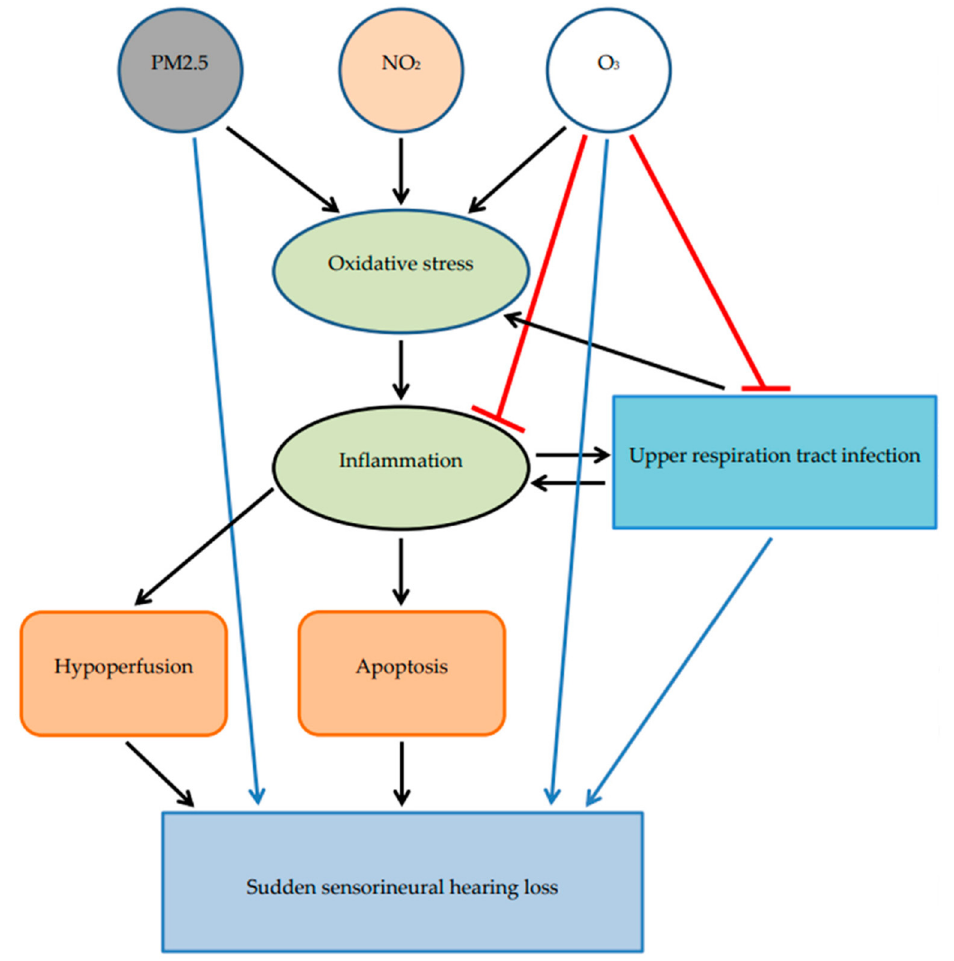
Figure 3. Possible mechanisms associated with air pollutants. The neurotoxicity of PM2.5 and O 3 directly affects cochlear cells (blue line). PM2.5, NO 2 , O 3 and upper respiration tract infection induce oxidative stress in the inflammatory pathway and cause apoptosis and hypoperfusion. Inflammation and upper respiration infection could interact and cause each other occur. (black line). PM2.5, NO 2 , and O 3 decrease the defenses of the upper respiratory tract, facilitating viral infections. Viruses directly infect cochlear cells (blue line) and induce oxidative stress and inflammation, causing SSHL. O 3 has an anti-inflammatory effect and can kill viruses (red line) via the confrontation effect [28–31]. There are some limitations in this study. First, atherosclerosis [42], migraine